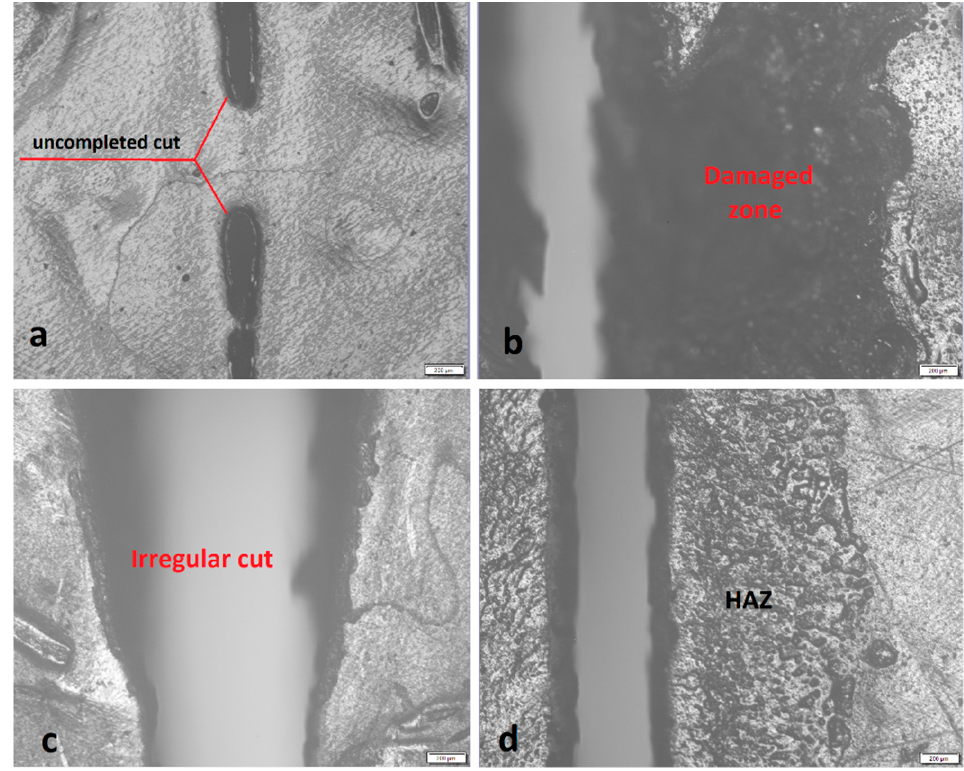
Figure 1. ( a ) Incomplete cut. ( b ) Observed damage at the cutting zone. ( c ) Irregular cutting kerf. ( d ) High depth of the heat-affected zone (HAZ).